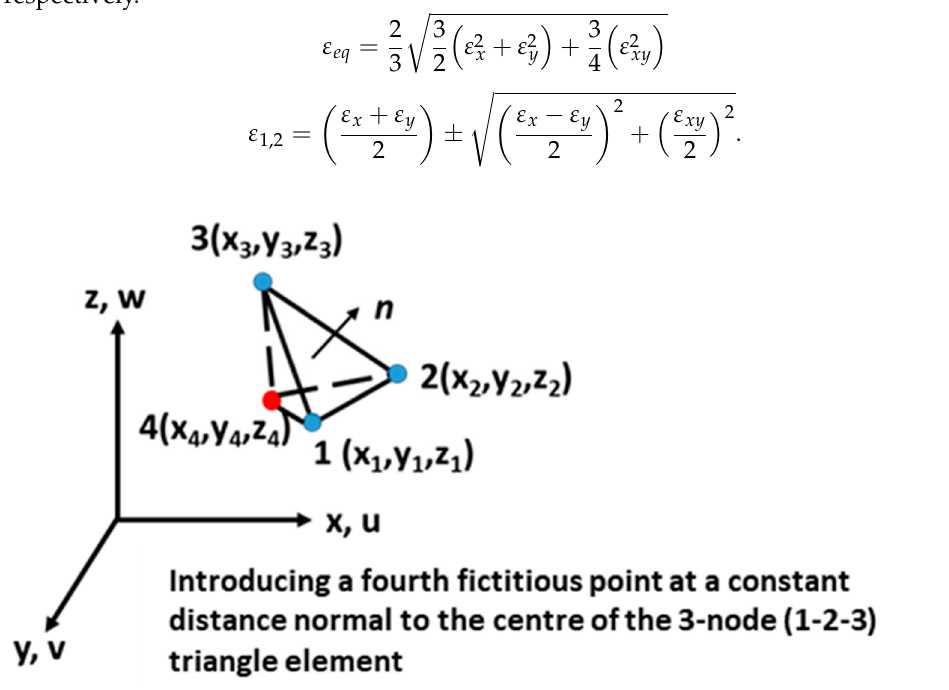
Figure 4. 3 + 1 node tetrahedral element.